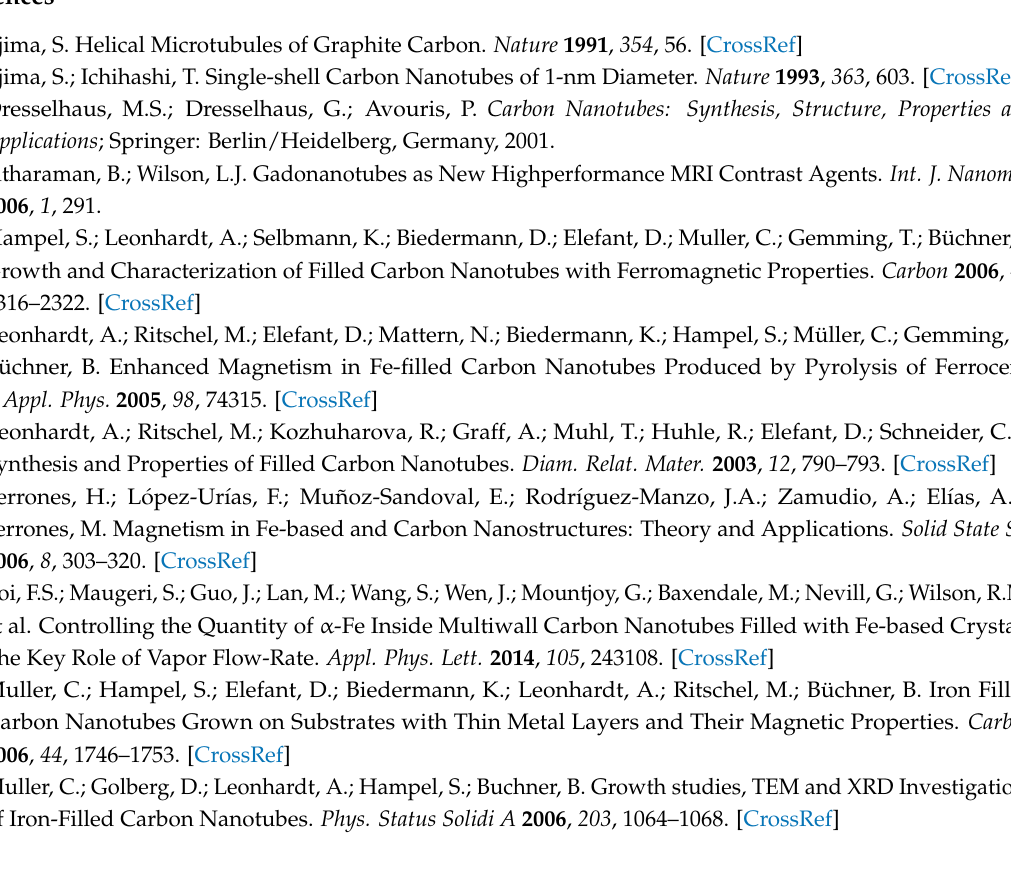
Figure S1: Statistical investigation of the outer diameter of the Fe 3 C-filled CNTs comprised in the buckypaper produced by using SBA-16 as growth promoter. Note that the average diameter was 79.2 nm, while the length of the CNTs (as evaluated in the SEM micrographs presented in the manuscript) was estimated to be in the order of many tens of micrometres (i.e., 50–100